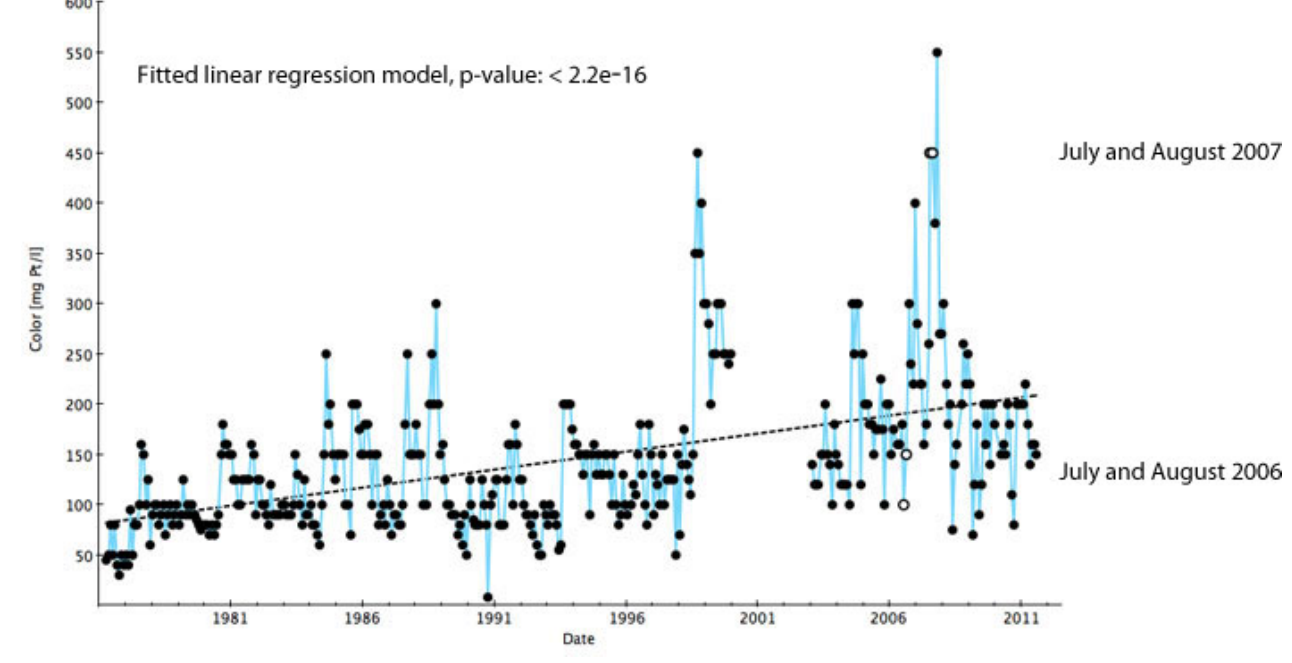
Fig. 2. Color of surface water in River Helge å as measured at Torsebro, where River Helge å enters the floodplain and the Kristianstads Vattenrike Biosphere Reserve. Linear regression using R (www.r-project.org) confirms a linear regression model as a significant fit (adjusted R²: 0.2573, F-statistic: 133.3 on 1 and 381 DF, p-value: < 2.2e-16). Markers for July and August 2007 and for July and August 2006. Source: Coordinated recipient monitoring (webstar.vatten.slu.se/db.html), hosted by SLU,